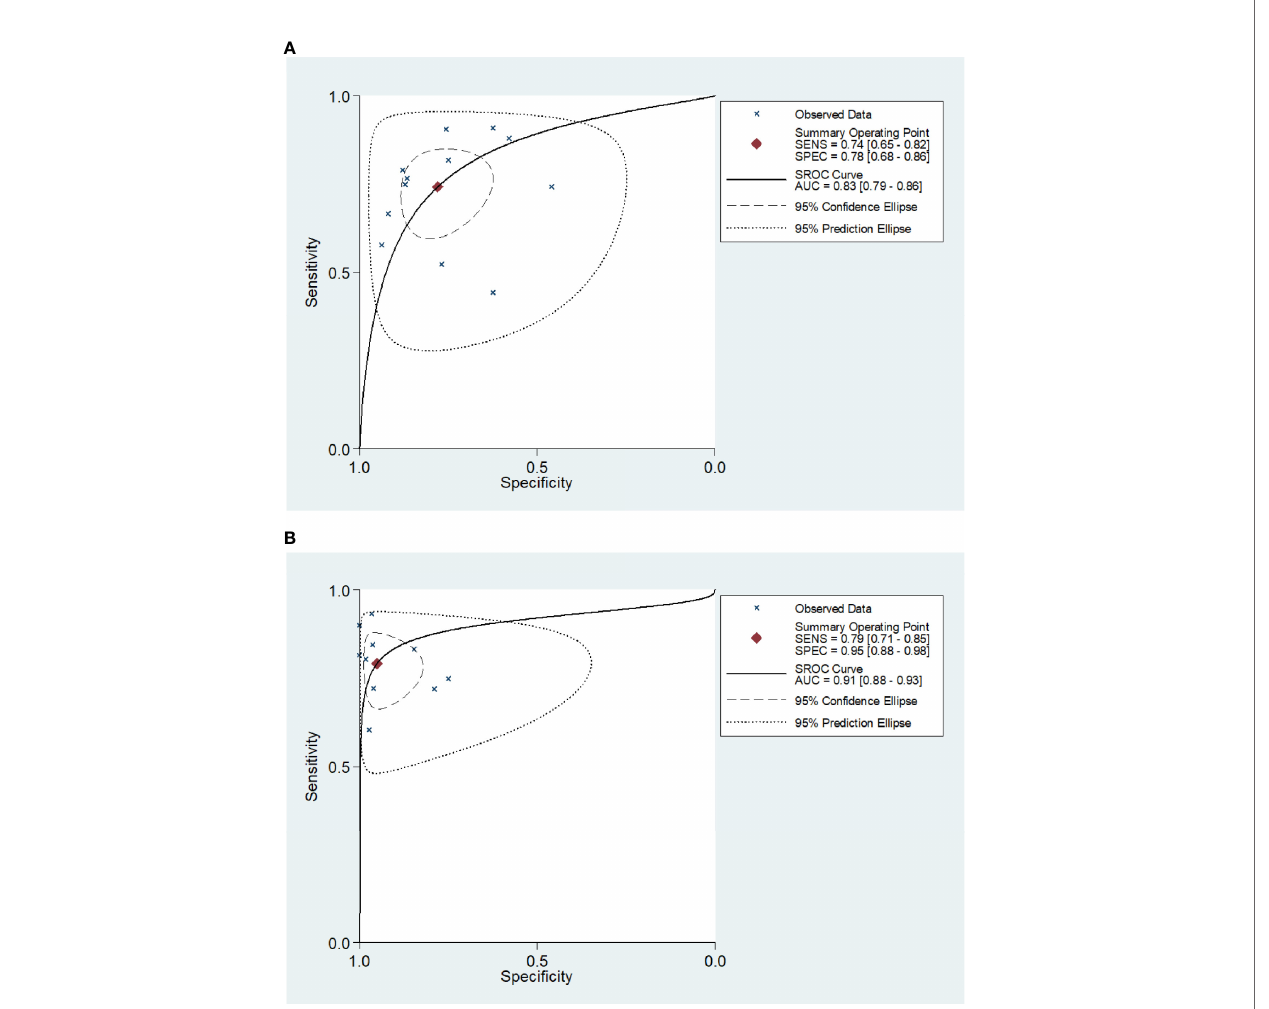
FIGURE 3 | Receiver operating characteristic curve of the IGRA for diagnosis of tuberculosis meningitis. The SROC curves for blood (A) and CSF IGRAs (B) . The AUCs were 0.83 (95% CI: 0.79-0.86) for blood IGRAs (A) and 0.91 (95% CI: 0.88-0.93) for CSF IGRAs (B)